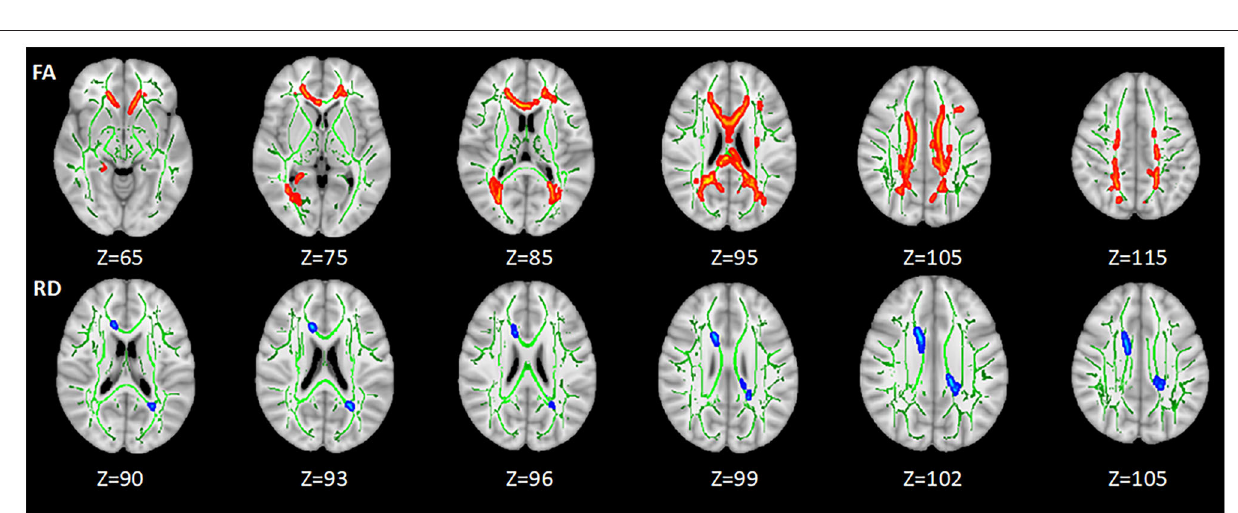
(ACR), SCR, posterior corona radiata (PCR), and posterior thalamic radiation (PTR) in HIV + /syphilis + ( p < 0.05). Higher